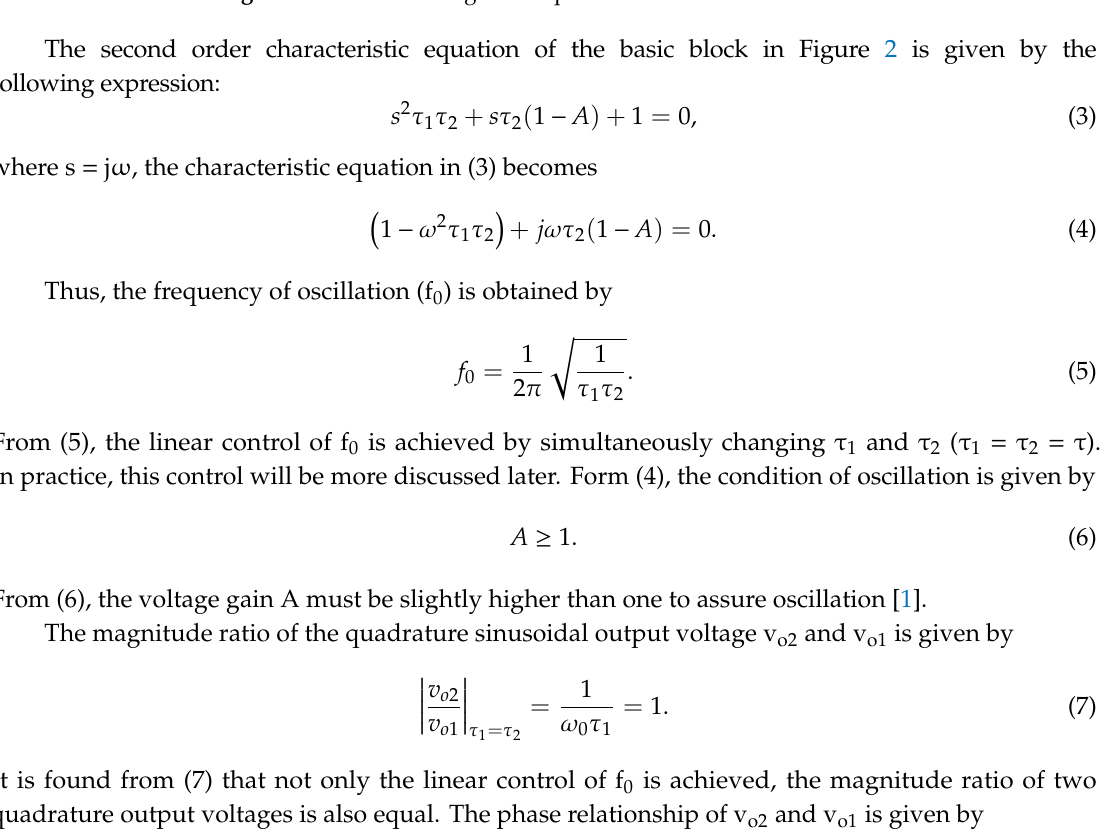
Figure 2. Basic block diagram of quadrature sinusoidal oscillator.